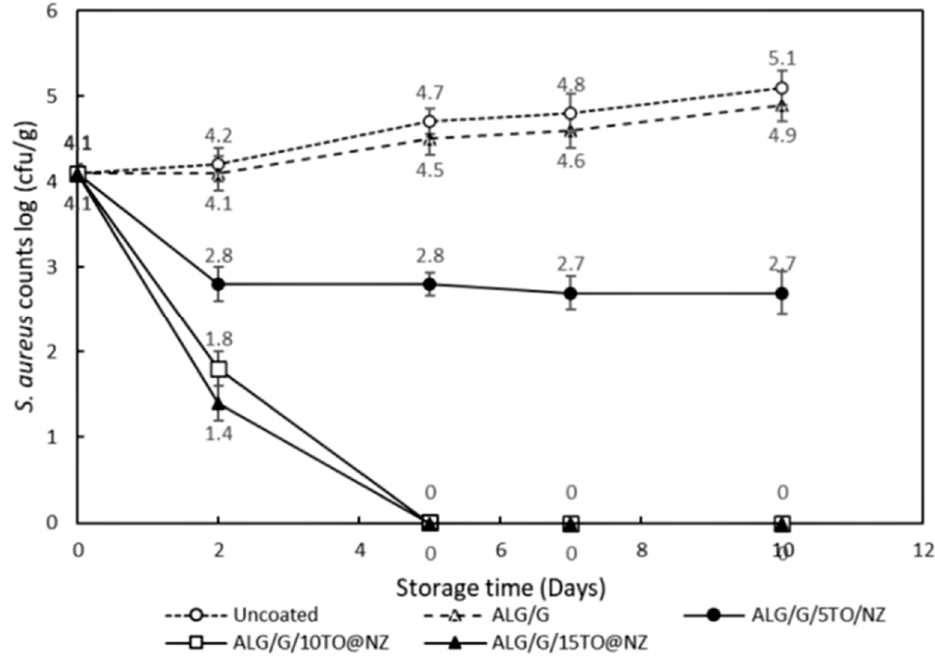
Figure 11. Changes in Staphylococcus aureus ATCC1534 counts in cottage cheese samples wrapped with alginate-based edible films (ALG/G/xTO@NZ) with the hybrid nanostructure TO@NZ in different concentrations.